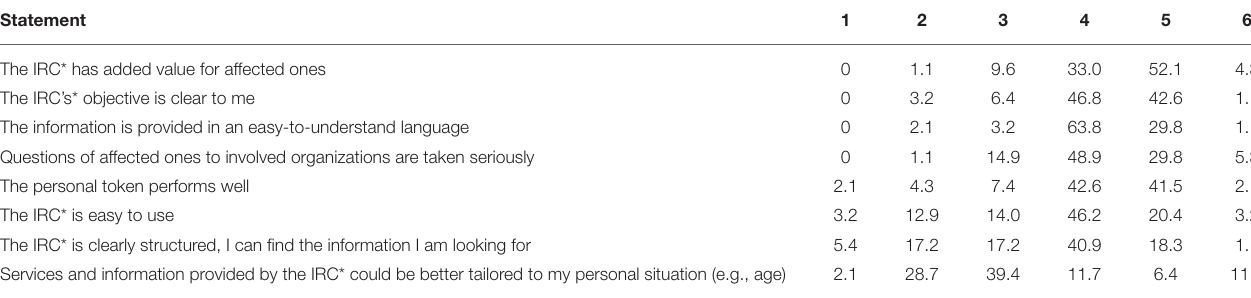
TABLE 2A | Survey results of affected ones (data source A); frequency distribution in % N =